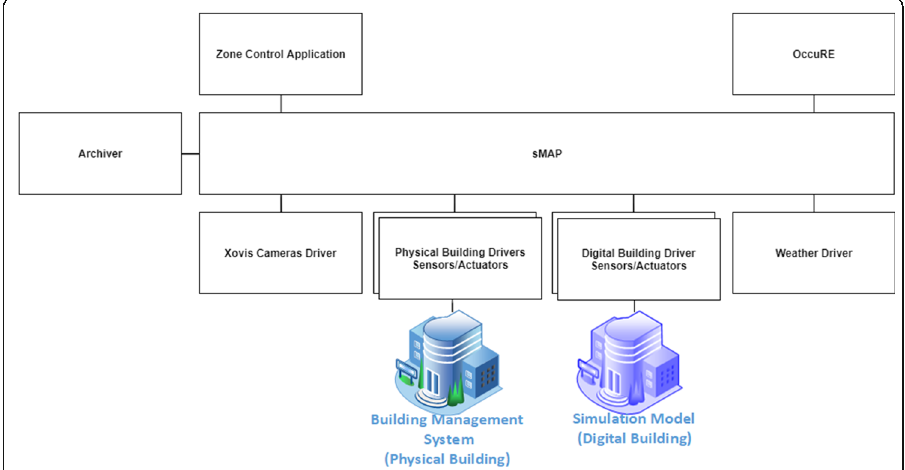
Fig. 1 Overview of the Digital Twin Framework